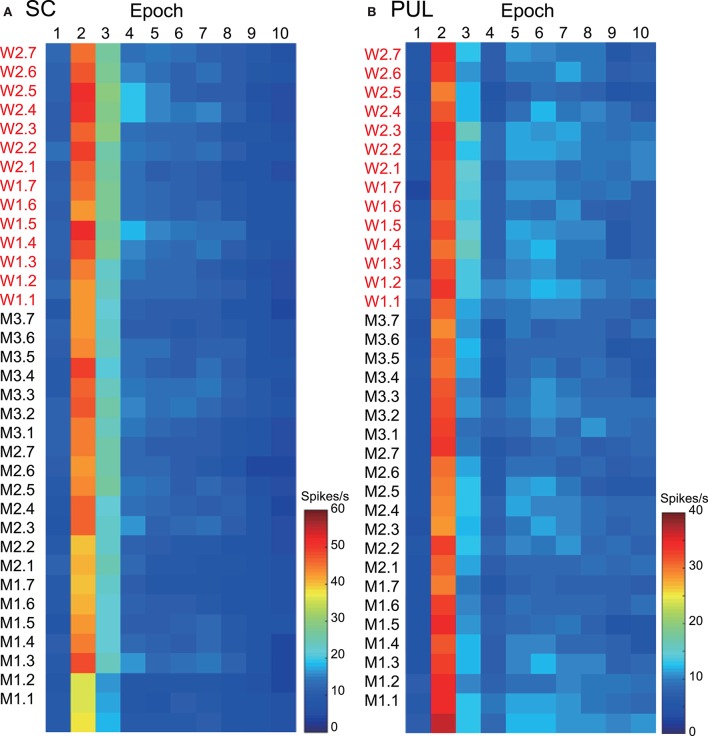
The temporal changes in the mean response magnitudes of the neurons in the superior colliculus (SC) (A) and pulvinar (PUL) (B) to the facial stimuli across the different epochs. The labels consisting of two letters (M or W) and the numbers on the left of the graphs refer to the 35 visual stimuli shown in Figure 1A; W1, W2, M1, M2, and M3 before the periods refer to the five models, and the 1 to 7 after the periods refer to the face orientation and gaze direction.